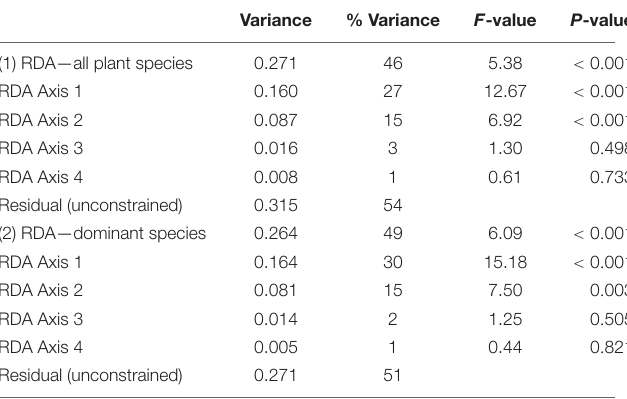
TABLE 2 | Results of redundancy analysis (RDA) exploring the congruence between plant species composition of litterfall and litter chemical traits over time. Variance % Variance F -value P